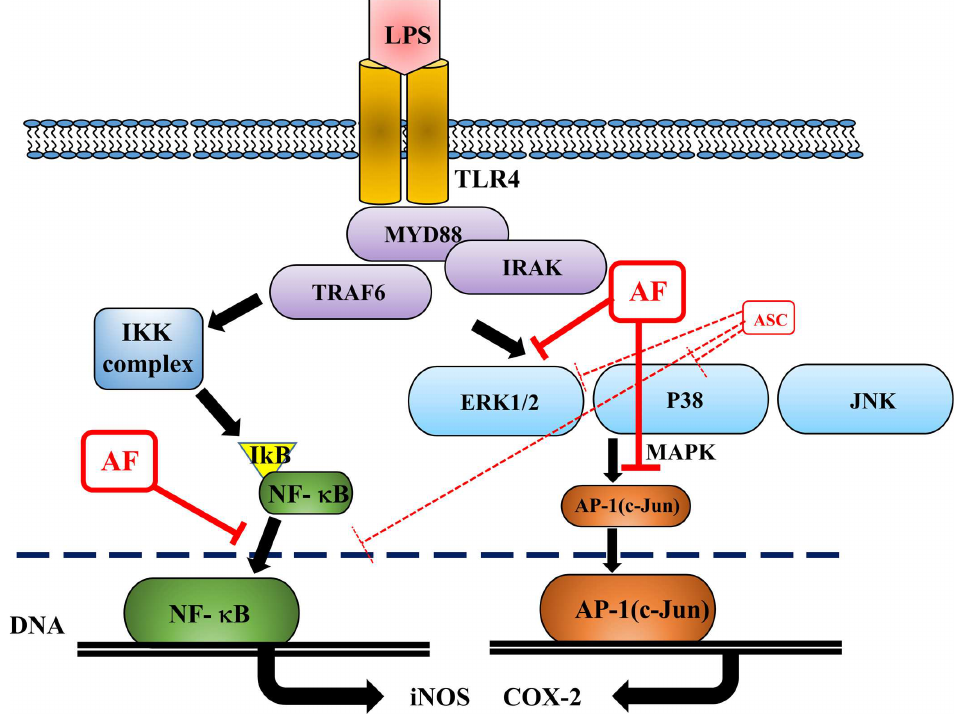
Fig 7. A schematic illustration of the anti-inflammatory activity of AF. AF suppressed the inflammatory responsein RAW264.7 macrophages through suppression of NF- κ B, AP-1(c-Jun), p-ERK1/2, TNF-a, IL-6, and